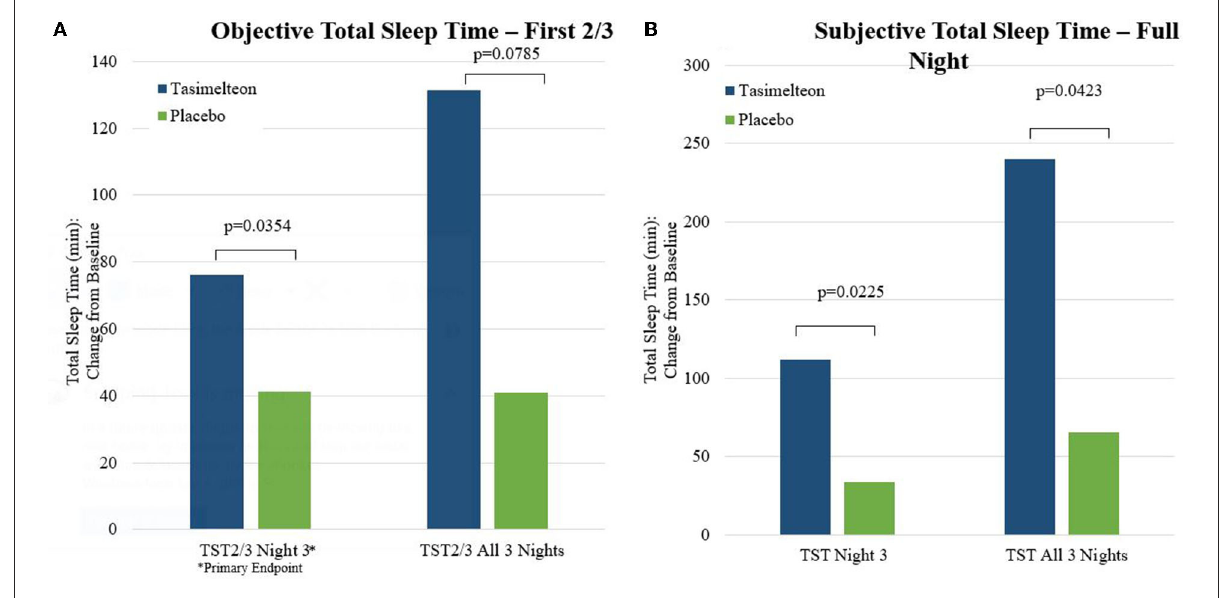
FIGURE4 Total sleep time—objective and subjective measures.